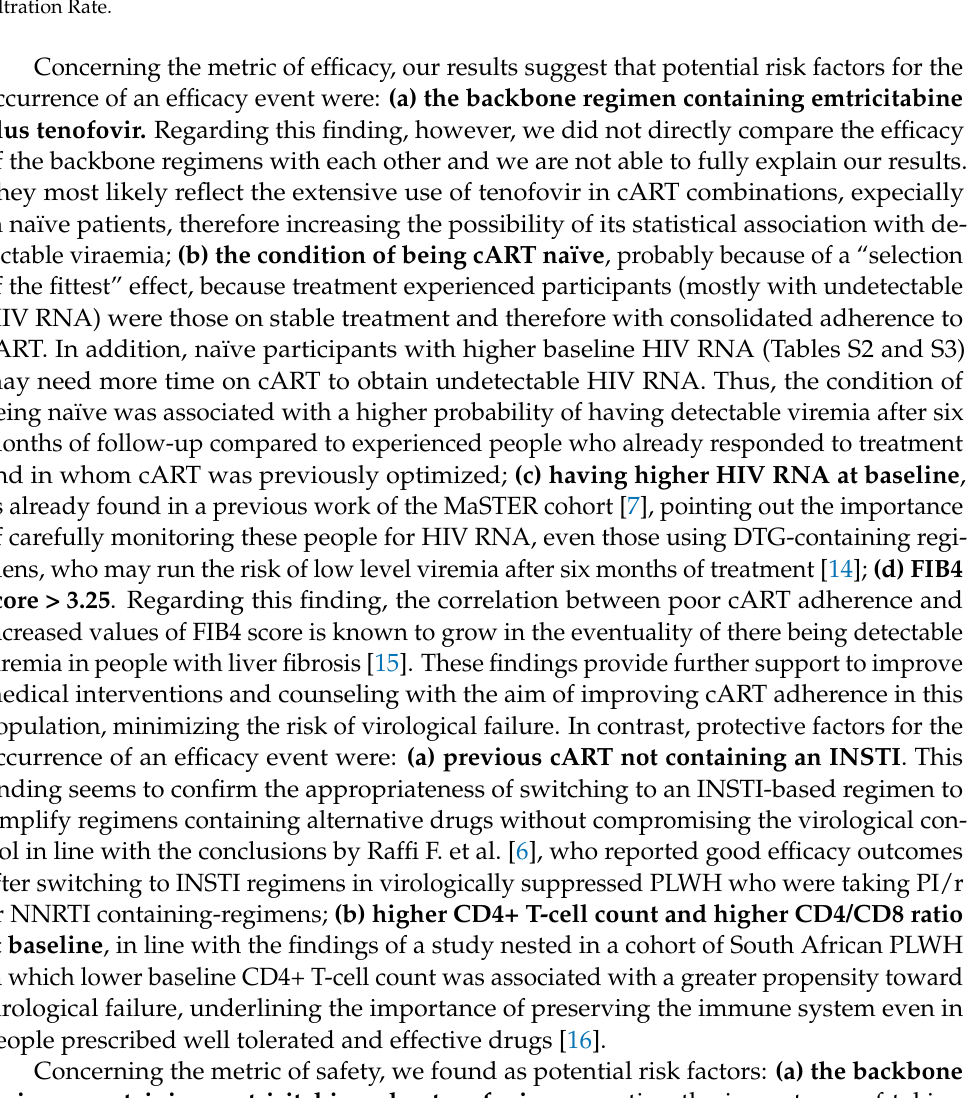
mated Glomerular Filtration Rate.